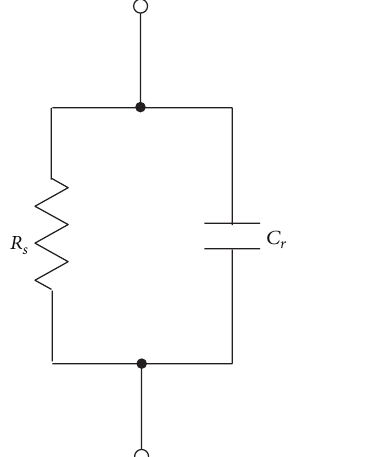
Figure 3: Parallel circuit of sliding contact site.